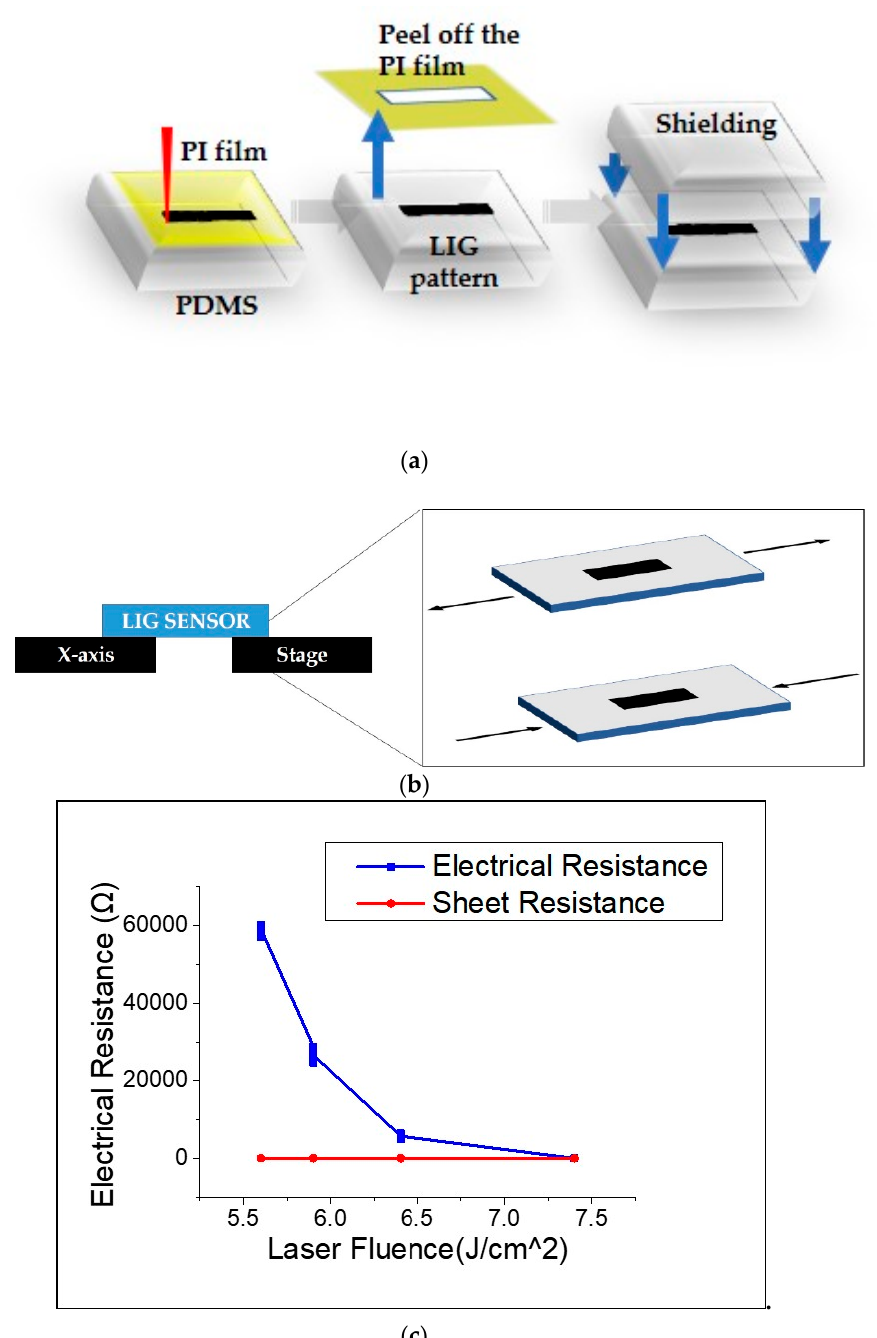
Figure 3. Fabrication of LIG sensor: ( a ) process of fabricating the LIG strain sensor, ( b ) strain generation by bending, and ( c ) changes in electrical characteristics according to laser fluence.